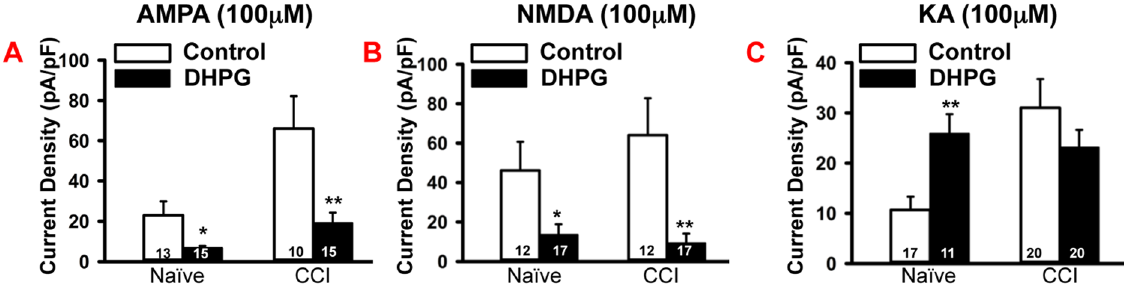
Figure 5. The effect of DHPG incubation on responses to AMPA, NMDA and KA in small diameter neurons. A. Incubation with 50 m M DHPG for 2 hours reduced AMPA-induced (100 m M) inward currents in small diameter neurons in both naı¨ve and CCI groups. B. Incubation with 50 m M DHPG for 2 hours reduced NMDA-induced (100 m M) inward currents in small diameter neurons in both naı¨ve and CCI groups. C. Incubation with 50 m M DHPG for 2 hours increased KA-induced (100 m M) inward currents in small diameter neurons in the naı¨ve group, but had no effect on KA- induced currents in the CCI group. Numbers in each column represents recorded neurons. Mean 6 SEM, * p , 0.05, **p , 0.01.